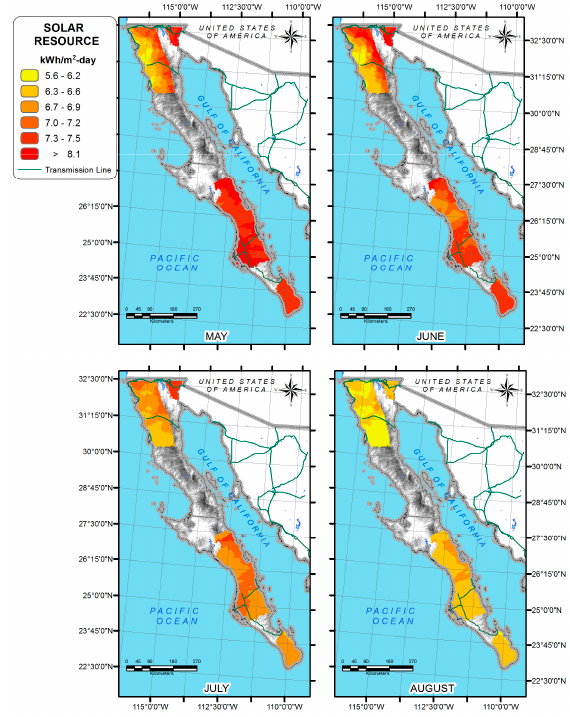
Figure 10. Irradiation at the Baja California Peninsula, May to August.